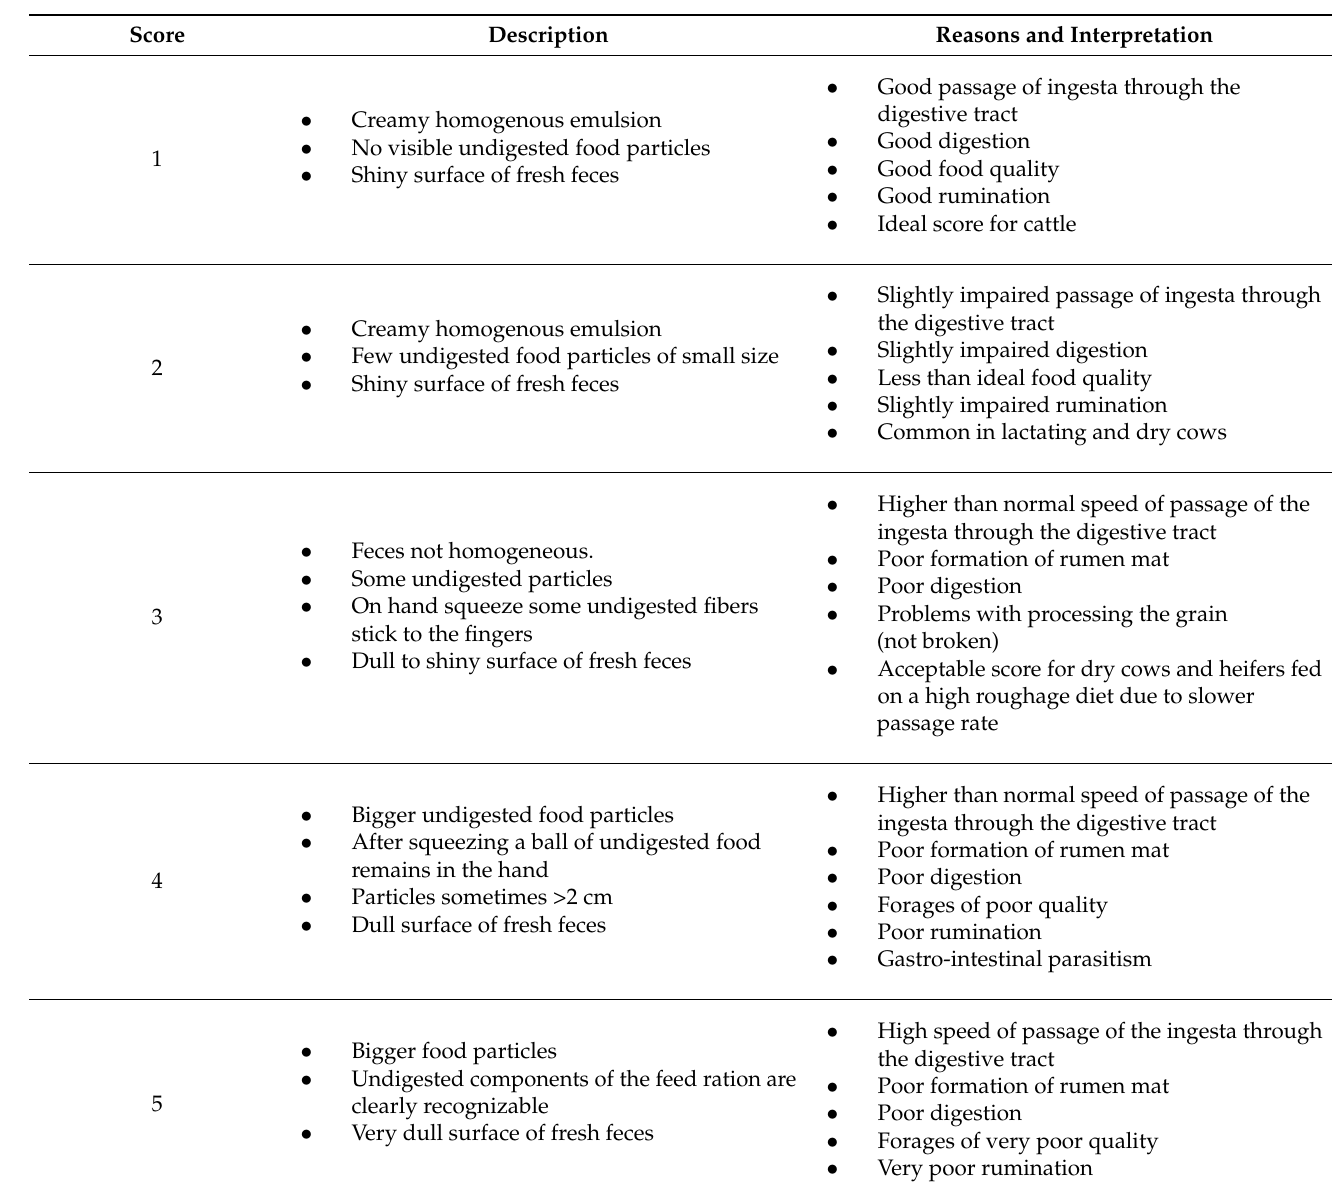
Table 5. Scoring of the digestive function by squeezing feces with a gloved